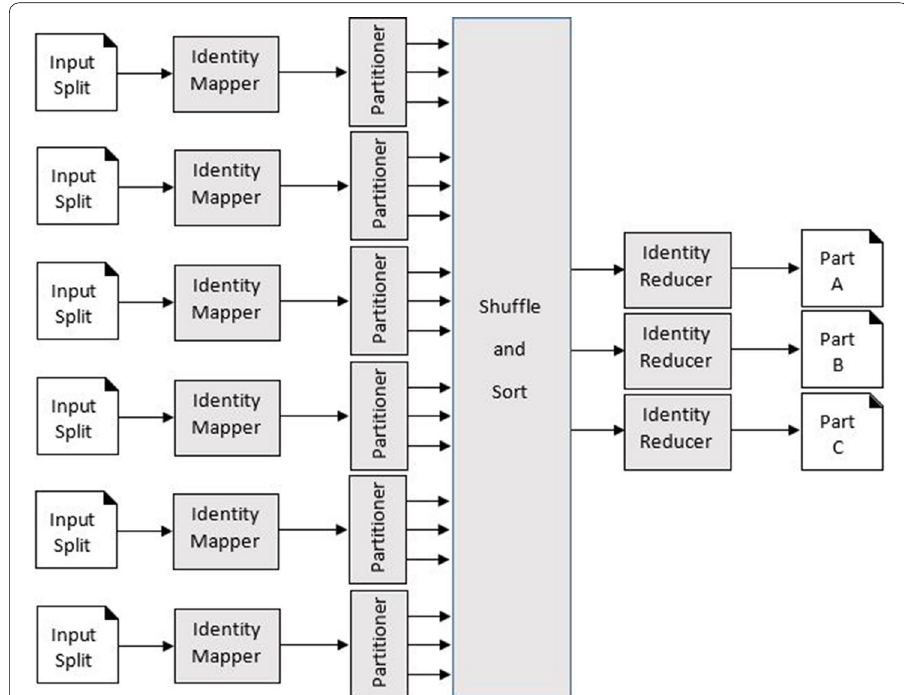
Fig. 1 Processing phases in MapReduce [12]. Mappers run on unsorted input key/value pairs. Each mapper emits zero, one, or multiple output key/value pairs for each input key/value pairs. The shuffle and sort phase is done by the framework. Data from all mappers are grouped by the key, split among reducers and sorted by the key. Each reducer obtains all values associated with the same